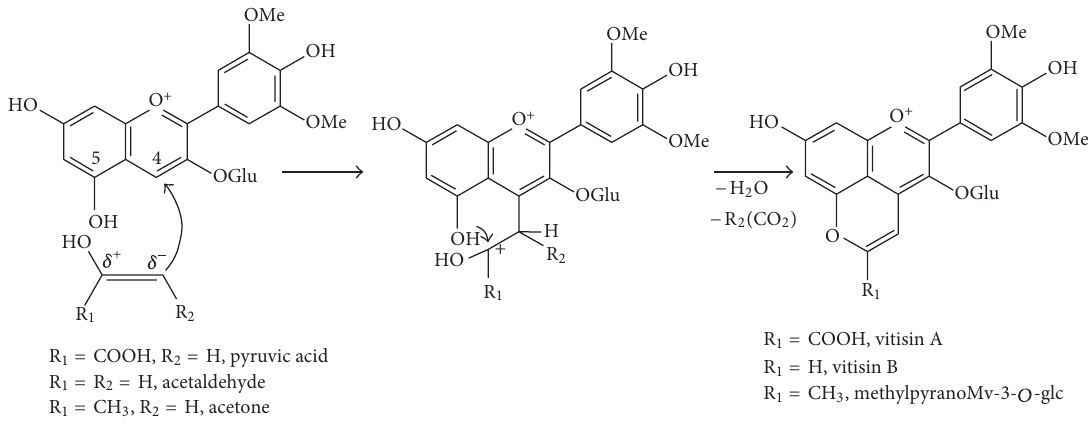
F 4: Formation of pyranoanthocyanin compounds by reaction between malvidin-3-glucoside and carbonyl compounds (enolic forms).